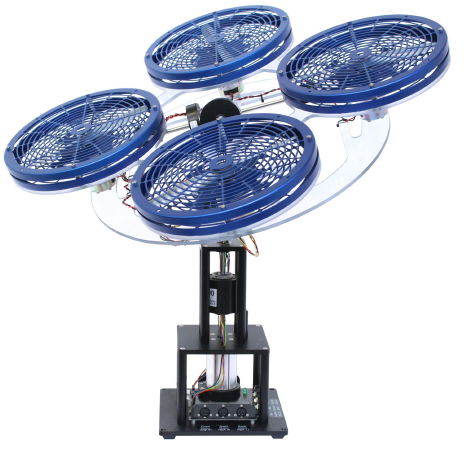
Figure 2. three DOF Hover prototype developed by